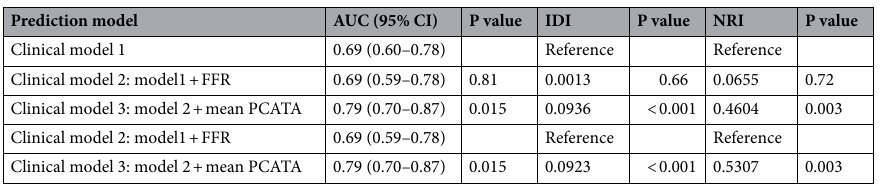
Table 5. Comparison of discriminant and reclassification ability of clinical models. To determine incremental discriminatory and reclassification capacities of mean PCATCA for predicting g-CFR < 2.0 Clinical model 1: age, male sex, DM, creatinine, cTnI at presentation, log (NT-proBNP), LV mass index, target lesion: LAD, Area at risk.